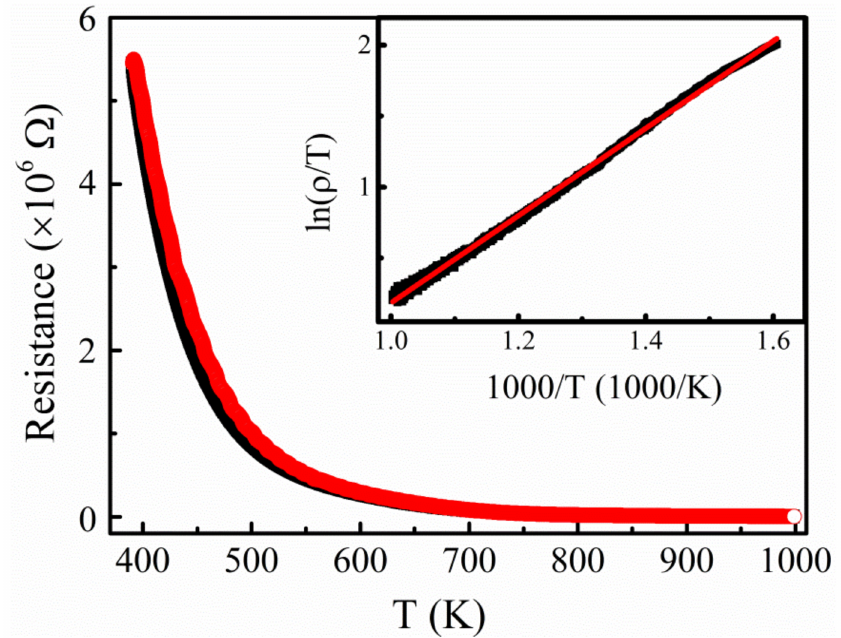
Figure 2. Temperature dependence of electrical resistivity of PBCC film in the oxygen atmosphere from 100 ◦ C to 750 ◦ C (373–1023 K); The inset is the relation of ln( ρ /T) vs. 1000/T of PBCC film in the oxygen atmosphere from 350 ◦ C to 750 ◦ C (623–1023